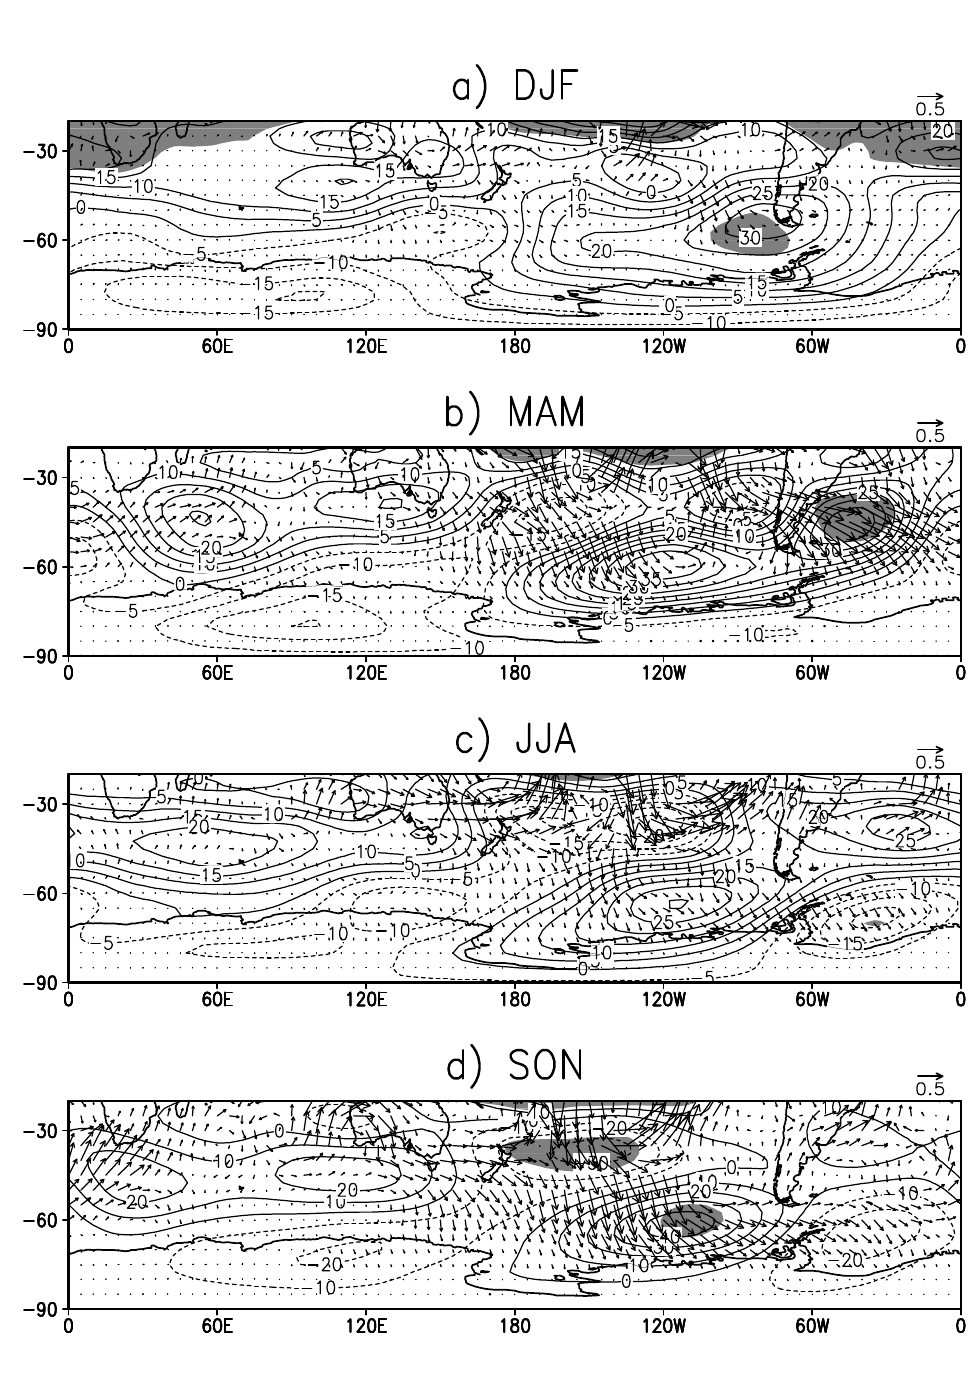
Fig. A3. Horizontal component of QS wave activity ( H c ) and geopotential height anomalies (El Ni˜no minus the mean) at 200hPa for the El Ni˜no composites for: (a) DJF, (b) MAM, (c) JJA, and (d) SON. Contour interval for height anomalies for (a), (b), and (c) is 5m and for (d) 10m. Vectors are in m 2 s − 2